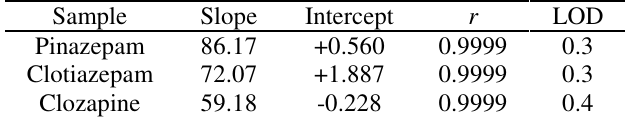
Table 1. Calibration parameters and limits of detection (LODs in ng mL -1 , 3s criterium ) for the determination of three benzodiazepines using the optimum mobile phase SDS130 mM -